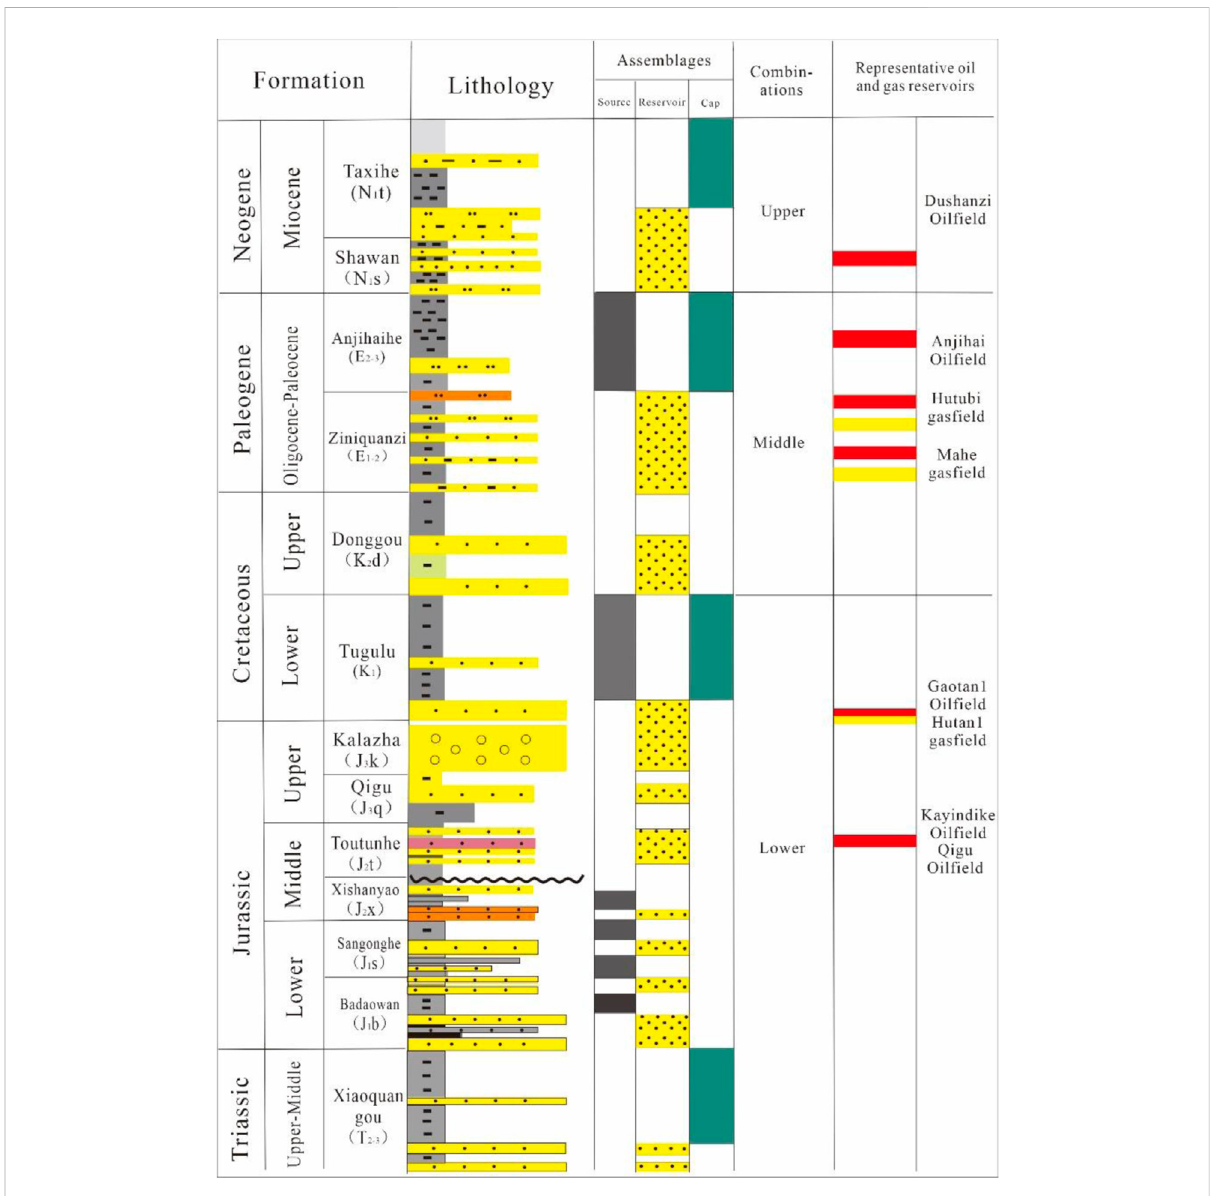
FIGURE 2 Stratigraphic chart and source-reservoir-cap assemblages in the STB of the Junggar Basin.